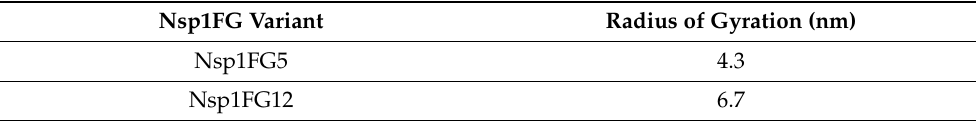
Table 1. Radii of gyration of Nsp1FG variants as determined from our molecular dynamics